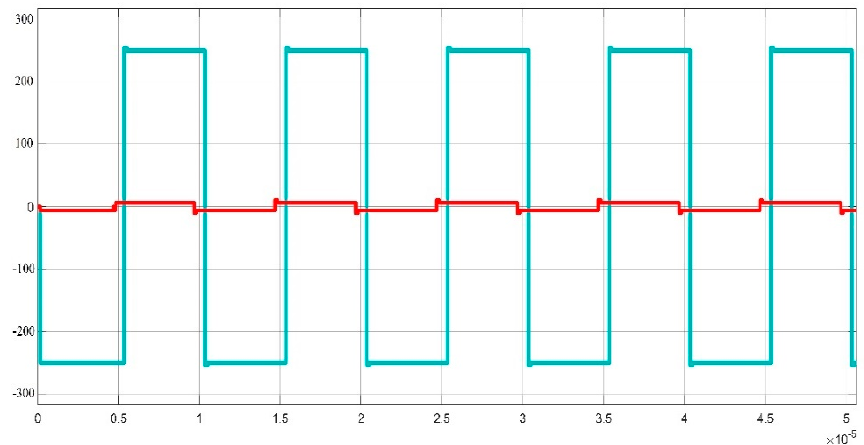
Table 6. Simulated and experimental results [10].